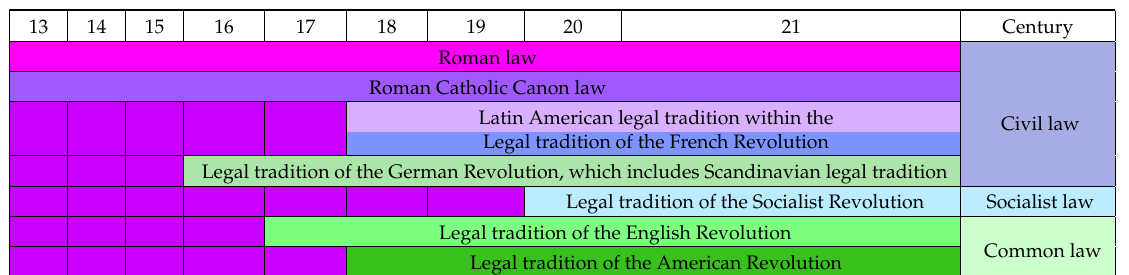
Table 2. Legal traditions in Europe and the Americas (Witte 2002; Berman 2003; Merryman and P é rez-Perdomo 2007; La Porta et al.